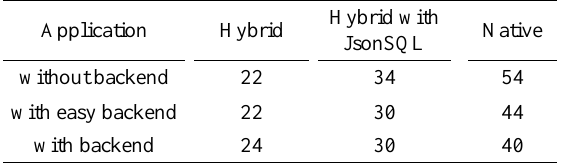
Table 1. Approximate development time, man-hours, necessary for different types of mobile applications with different